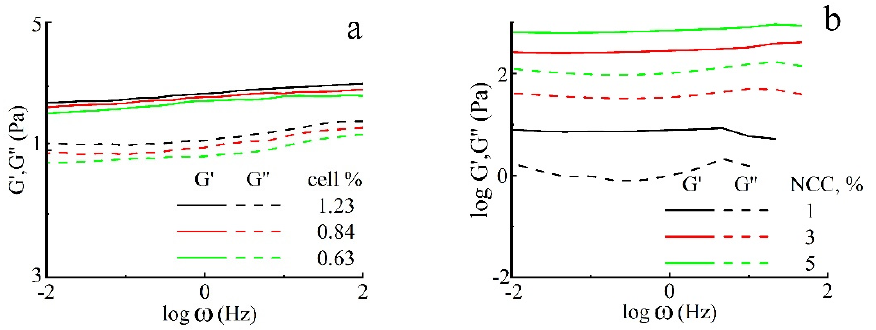
Figure 10. Dependences of elastic and loss moduli on oscillation frequency at strain of 0.01% for dispersions containing 0.63%, 0.84% and 1.23% of BC ( a ) and for dispersion with 1.0%, 3.0% and 5.0% of NCC ( b ) at 25 °C.